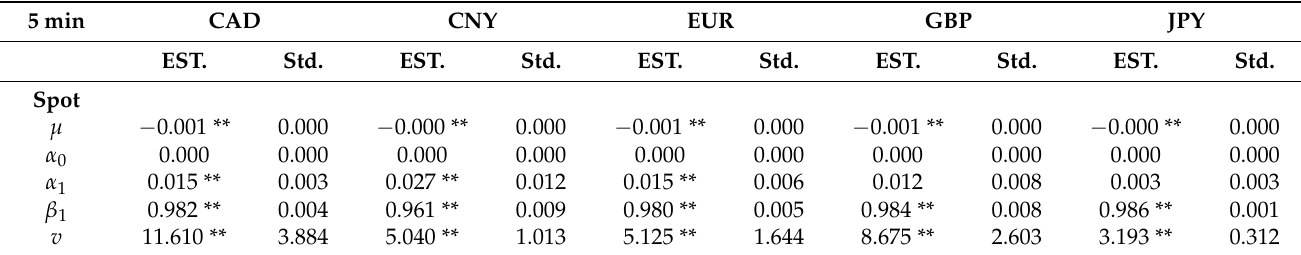
Table 3. Results from the GARCH (1,1) model estimation for 5-min spot and future